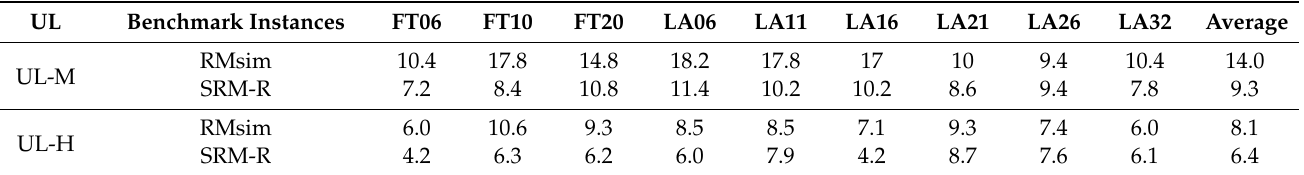
Table 4. The value of